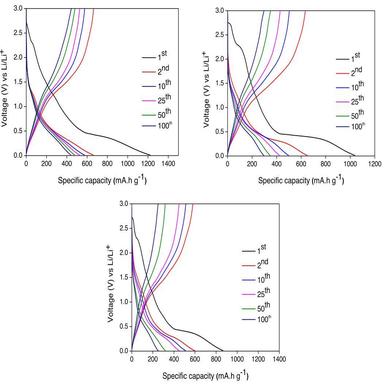
Charge–discharge profile of MoO3 prepared at (a) (1:1) (b) (1:1.5) (c) (1:2) nanoparticles at a rate of 0.1C.